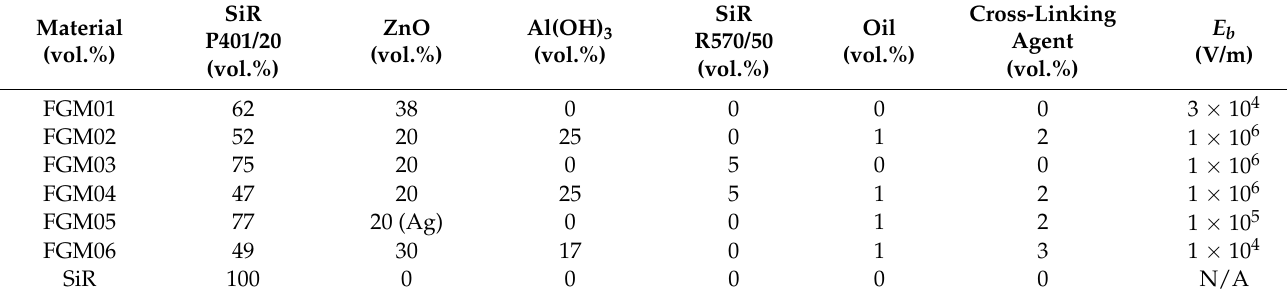
Table 9. Material compositions and switching field for multifunctional silicon rubber composites [53]. Material (vol.%)